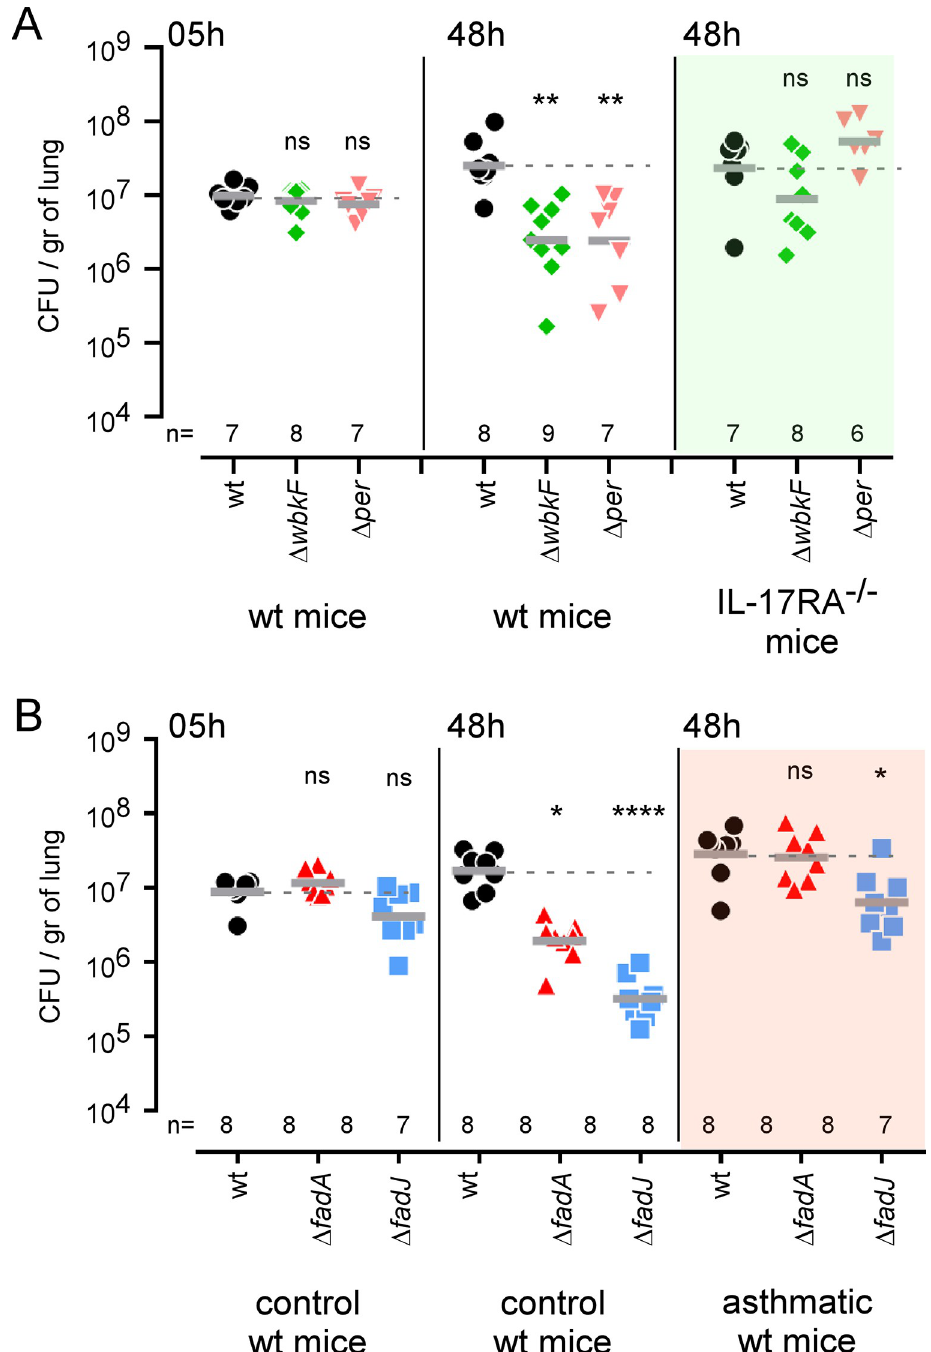
Fig 11. Functional confirmation of the prediction derived from the Tn-seq analysis of the IL-17RA -/- and asthmatic conditions. A. Data shown are bacterial count (CFU) at 5 and 48 hours post-infection in wild-type and IL- 17RA -/- mice infected intranasally with wild-type (wt), Δ wbkF and Δ per strains of B . melitensis at a dose of 5x10 6 CFU. B. Data shown are bacterial count (CFU) at 5 and 48 hours post-infection in control and asthmatic wild-type mice intranasally infected with wild-type, Δ fadA and Δ fadJ strains of B . melitensis at a dose of 5x10 6 CFU. Significant differences between wt and the indicated groups are marked with asterisks: � p < 0.1, �� p < 0.01, ���� p < 0.0001, in a One-Way ANOVA with Kruskal-Wallis post-test. These results are representative of three independent experiments.